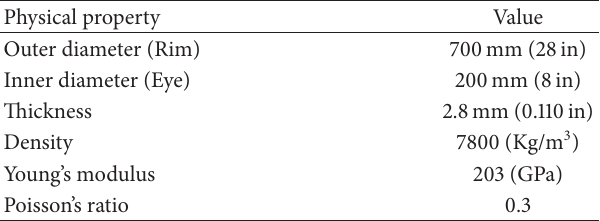
Table 1: The physical properties of the disk under